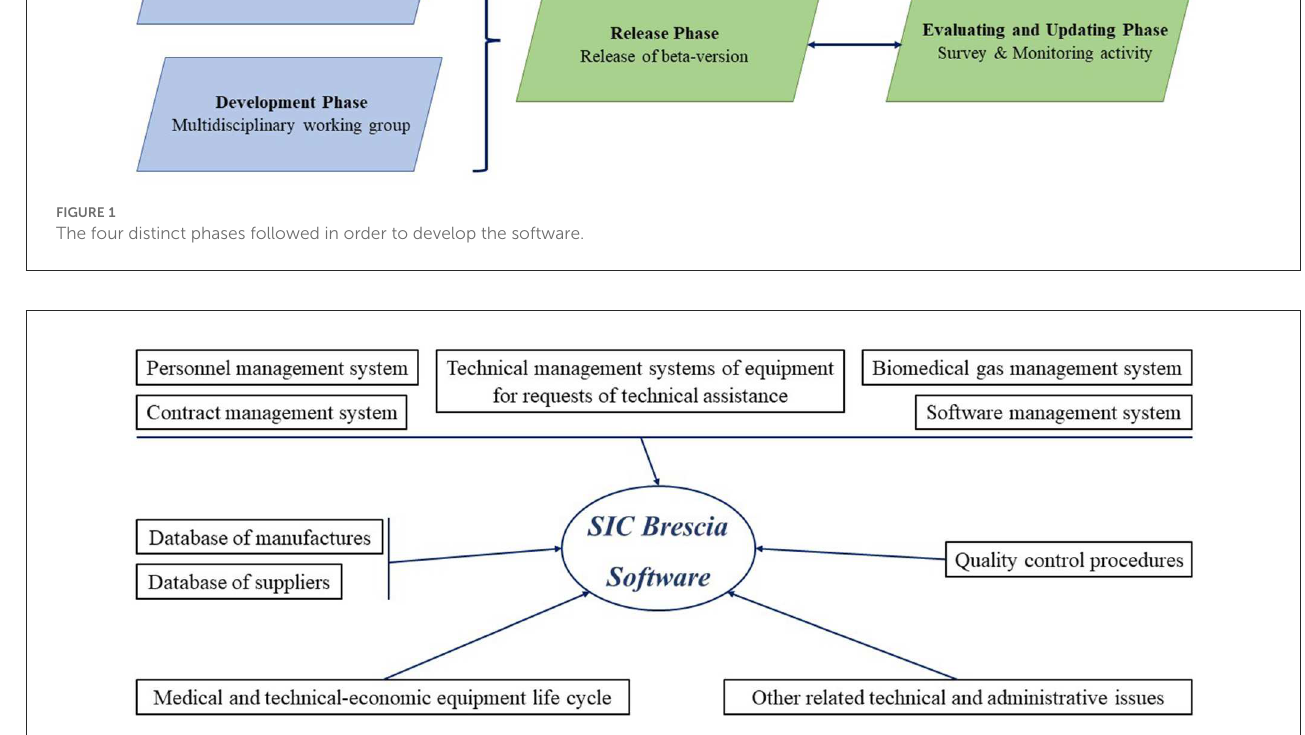
FIGURE2 All aspects related with Clinical Engineering Management that has been implemented in software’s